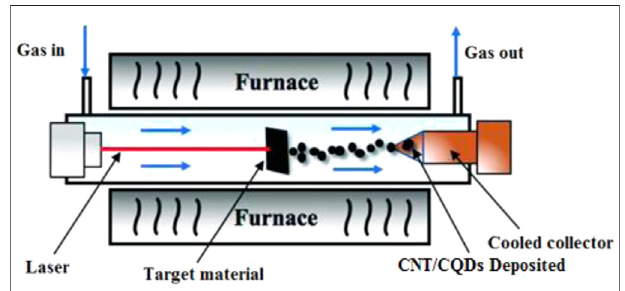
FIGURE 4 | Diagram depicting the progression of CNT/CQDs formation using the laser ablation process. This image was modi fi ed and reprinted with the permission from Zan Lu et al.